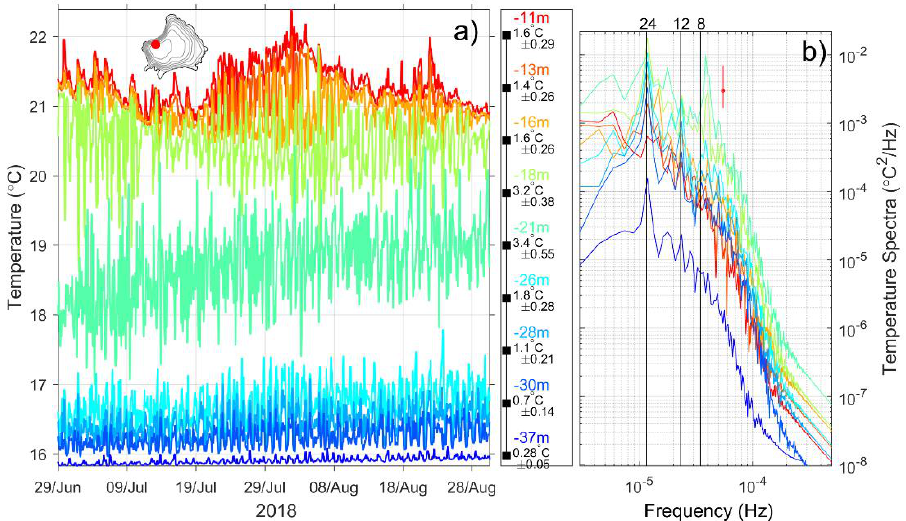
Figure 7. Thermistor chain time series in ( a ) for the field campaign from 29 June to 31 August. The colored lines correspond to the thermistor depths. Inset map shows the location of the thermistor chain in the lake. In the right side, every thermistor is shown in color-coded manner, the position in meters (first number), amplitude range in ◦ C (second number), and standard deviation in ◦ C (third number). Next, toward the right in ( b ), the temperature power spectral density is shown. The three top numbers correspond to periods in hours. The red bar is the 95% confidence interval.